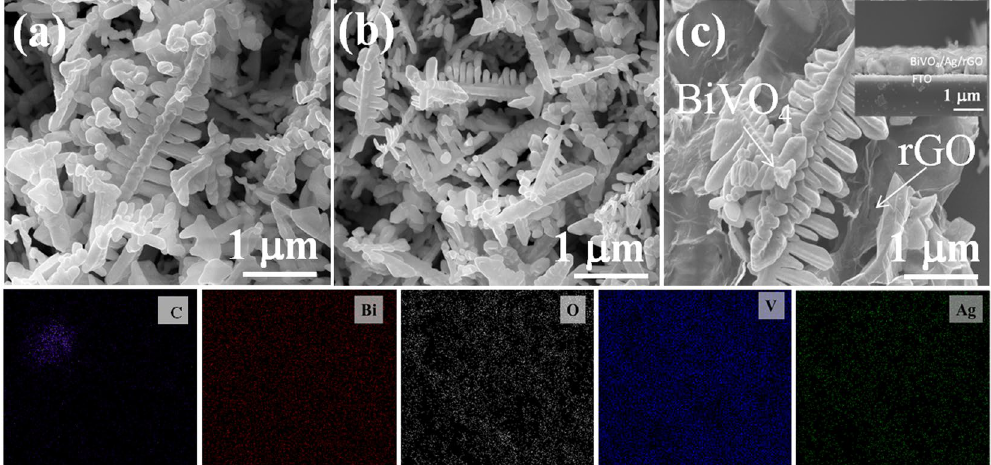
Figure 3. FESEM micrographs of ( a ) BiVO 4 , ( b ) BiVO 4 /Ag2%, and ( c ) BiVO 4 /Ag2%/rGO hybrid architectures and the corresponding EDS mapping images.